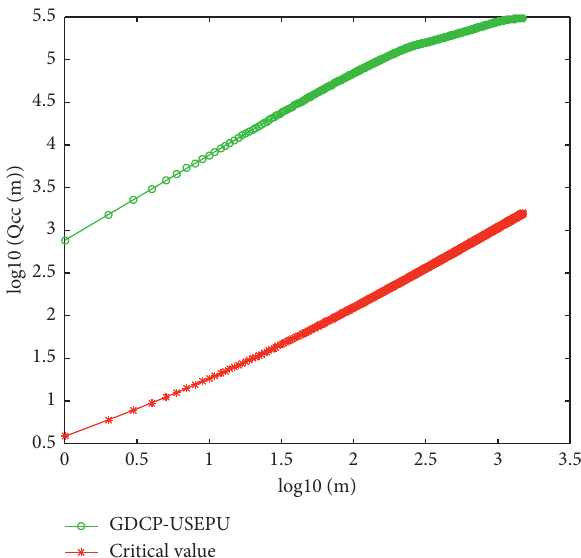
Figure 3: Log − log plot of the cross-correlation statistics ( Q